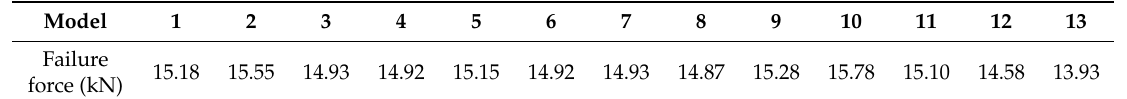
Table 5. Failure force of hybrid joints